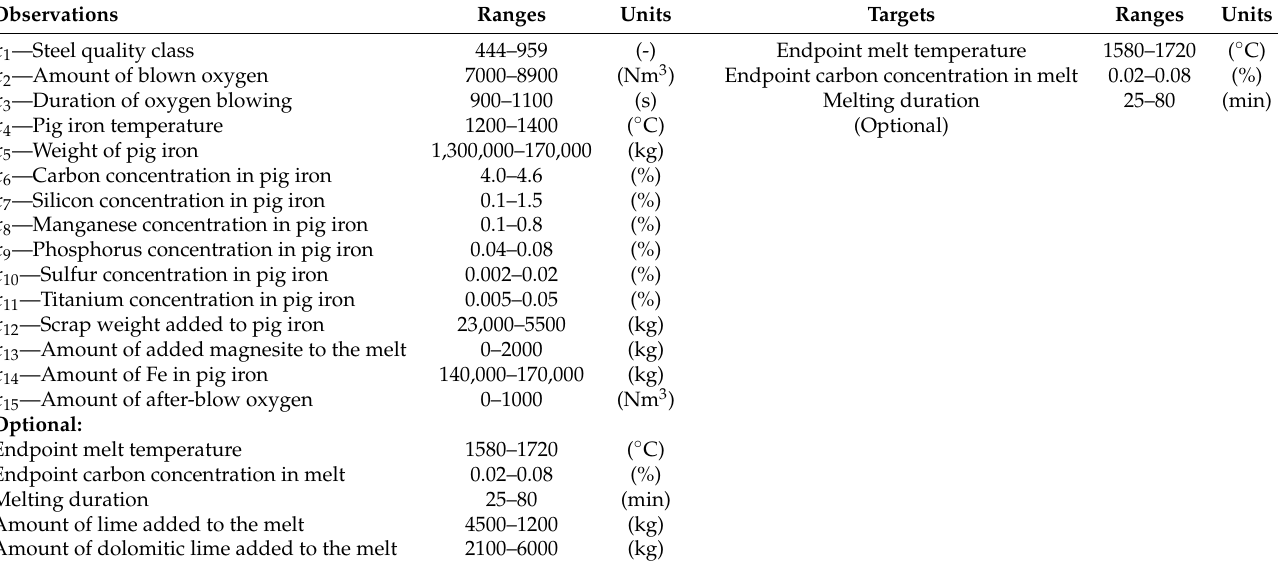
Table 1. Static observations and targets with measurement